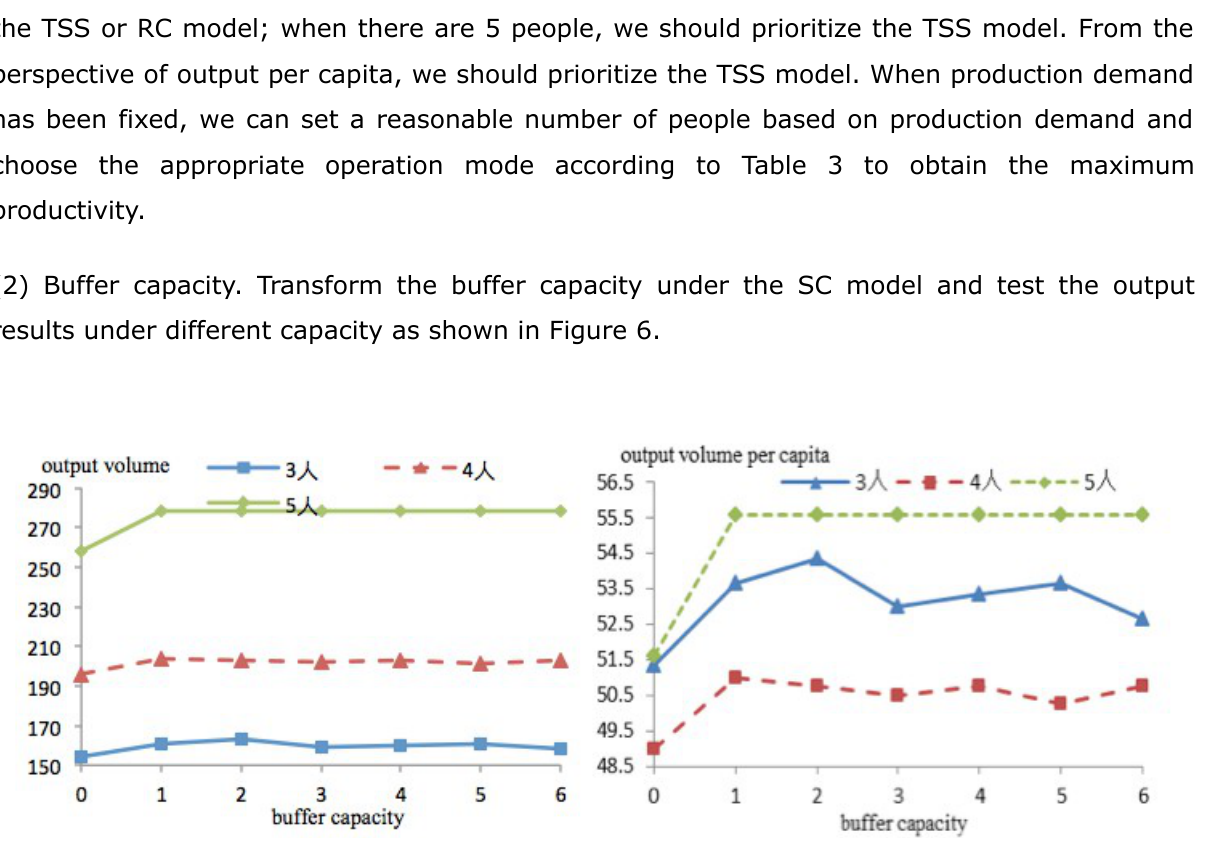
Figure 6. Impact of buffer capacity under SC